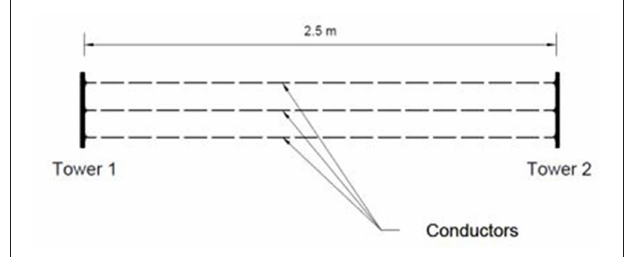
FIGURE 2 | Layout of tested conductor